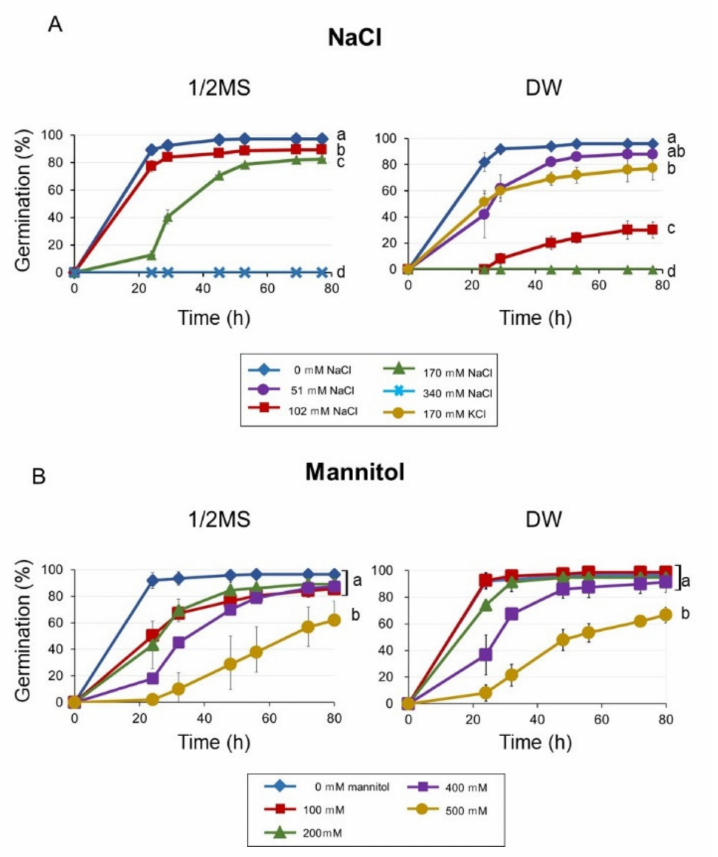
Figure 1. Seed germination on 1 / 2 MS or distilled water (DW), in the presence of several concentrations of NaCl ( A ) and mannitol ( B ) Seeds were stratified for three days before incubation at 23 ◦ C.